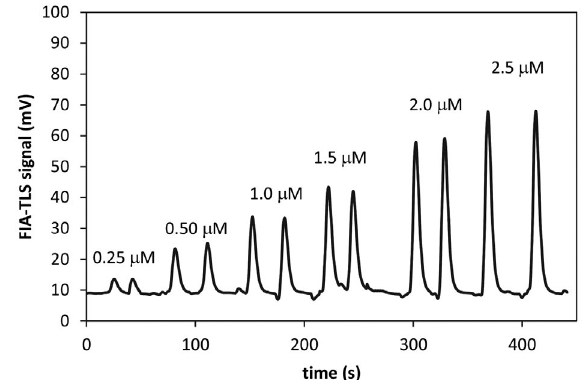
Figure 6. The TLS signal peaks of Fe(II) with 1 mM PHN as carrier solution